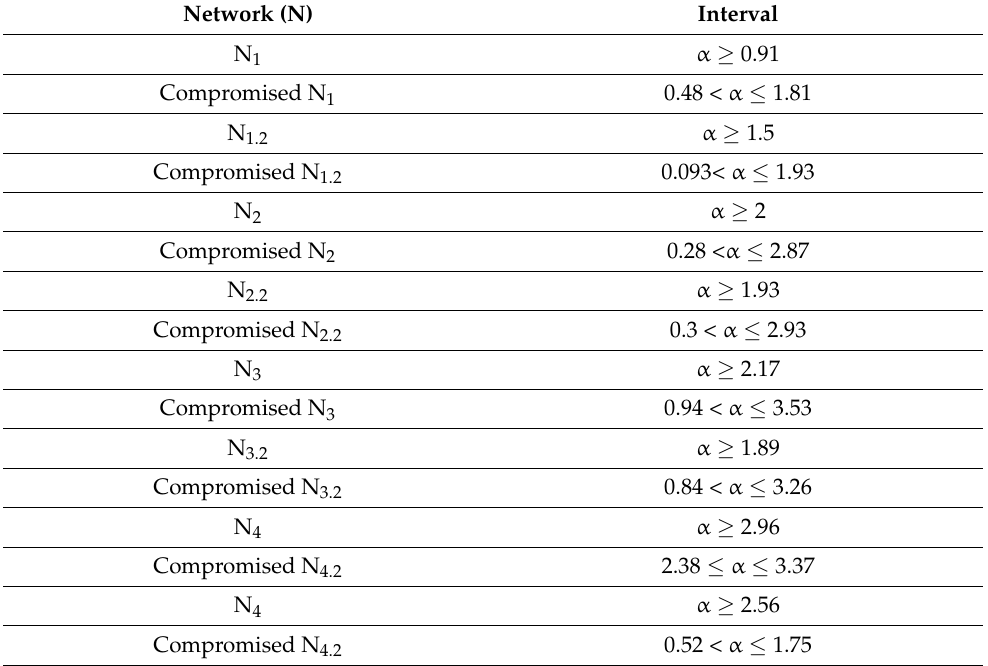
Table 3. The intervals of the variable α according to each network.